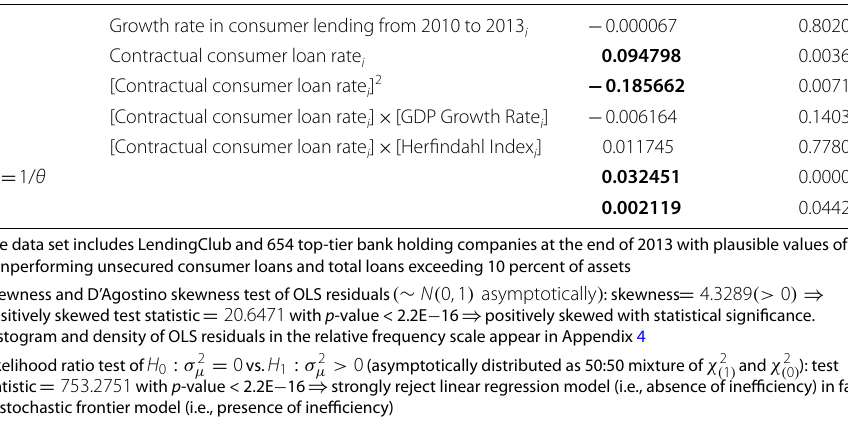
Table 7 2013 unsecured consumer loans–stochastic frontier estimation. Excluding the volume of unsecured consumer lending. Best‑practice (minimum) ratio of nonperforming consumer loans